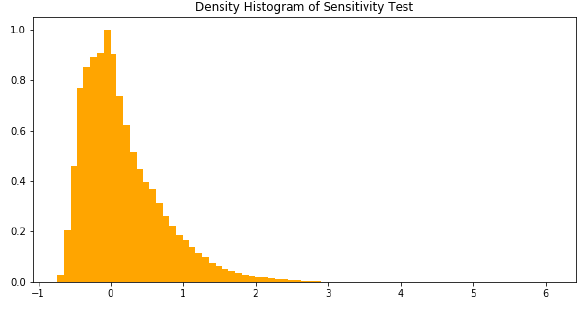
Figure 8. Histogram of sensitivity